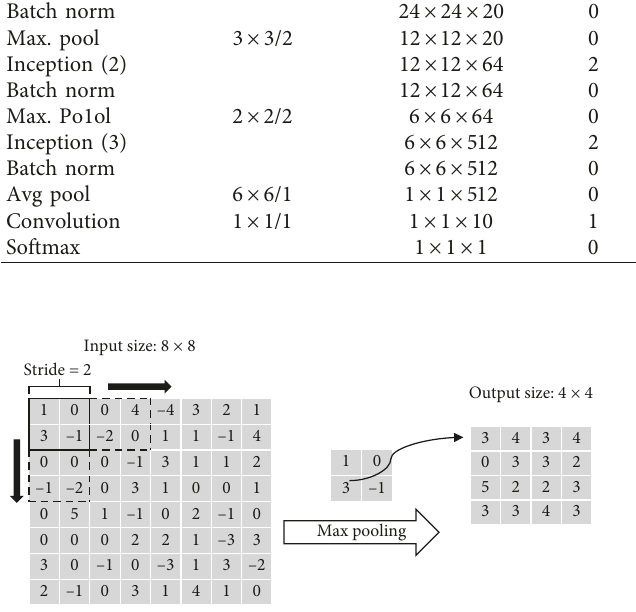
Figure 7: Pooling example: output size